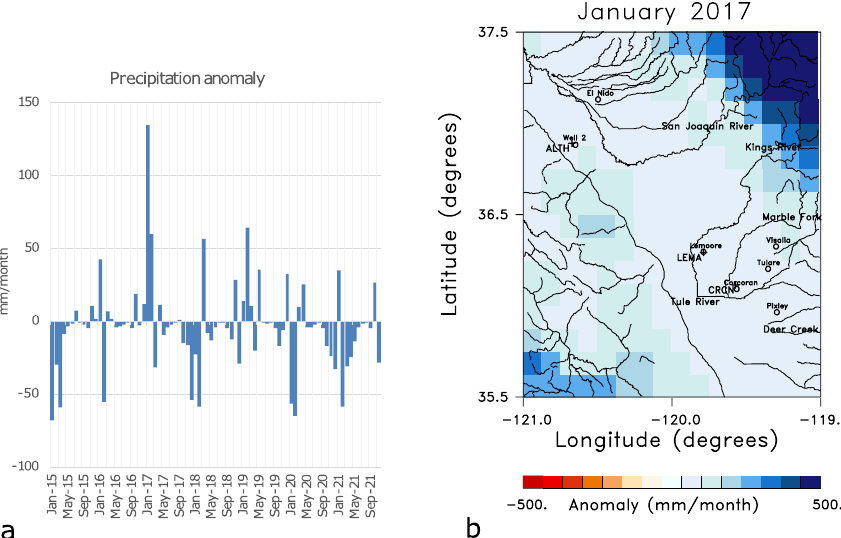
Figure 6. Precipitation data used as a forcing function for Phase 2 of the North American Land Data Assimilation System (NLDAS-2) 17 . The precipitation data extends from 1979 to the present at a spatial resolution of 0.125 degree and the monthly precipitation fields are accessible from the NASA Goddard Earth Science Data and Information Services Center [see NLDAS_FORA0125_M.002 doi:10.5067/Z62LT6J96R4F]. ( a ) Precipitation anomaly time series for the entire study area from the beginning of 2015 to the end of 2021. The anomaly is in millimeters per month. (b) Map of the precipitation anomaly for the area for the excessively wet month of January 2017. The map in panel ( b ) was constructed using NCL and NCAR Graphics 6.5.0 (https:// www. earth syste mgrid. org/ datas et/ ncl. 650. html).